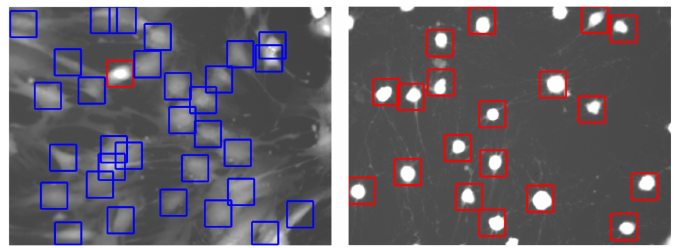
Figure 9. Classification results. Adherent cells are marked with blue squares, while rounded cells are indicated by red